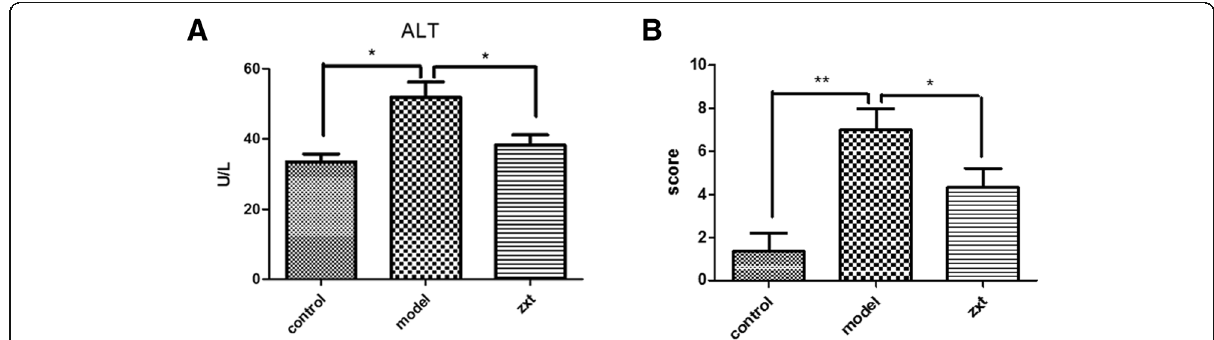
Fig. 2 The Alisma and Rhizoma decoction attenuates MCD-induced liver injuries. Mice were randomized to receive the regular diet and 2 mL distilled water (group I), the methionine and choline diet (MCD) and 2 mL distilled water (group II), or the MCD and 2 mL Alisma and Rhizoma decoction (4.31 g/kg) (group III) by gastric lavage. a Serum ALT content in each group. b NAS scores in each group. * P < 0.05, ** P <